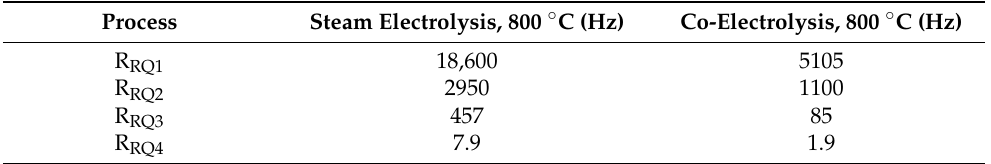
Table 3. Relaxation processes frequency obtained by impedance spectroscopy after 1000 h, for steam